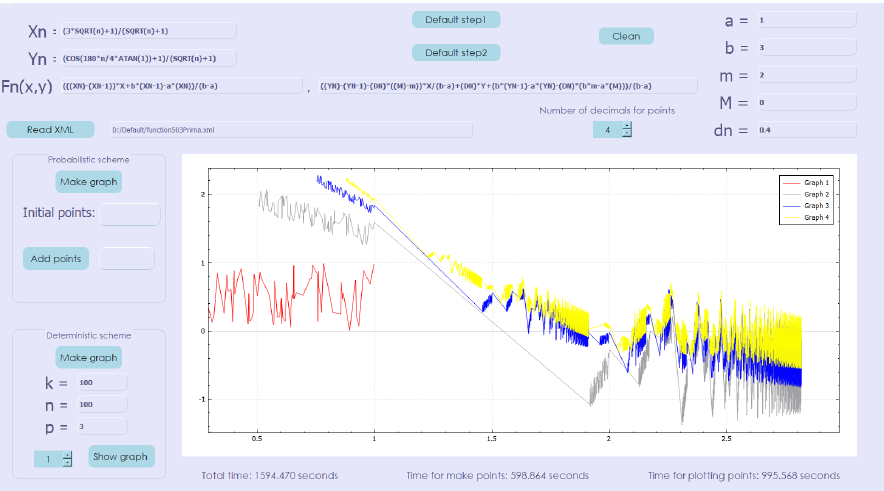
Figure 7. Affine deterministic interpolation scheme (approximation with 100,000,000 points, step by